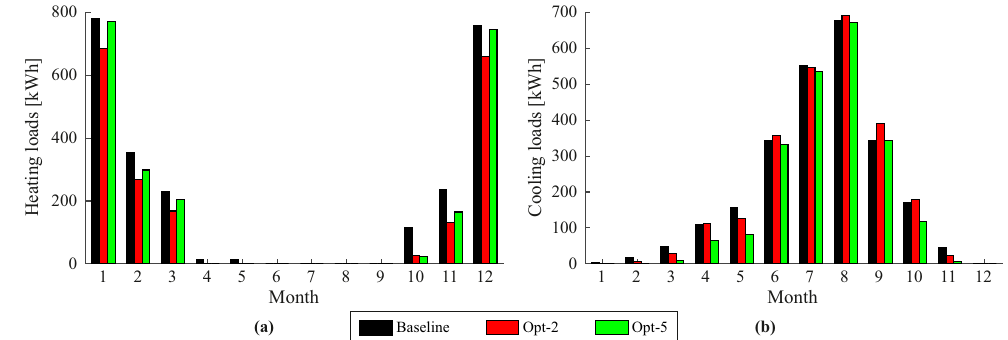
Figure 10. Monthly loads for the designs Opt-2 and Opt-5, and the baseline model. ( a ) Heating loads; ( b ) Cooling